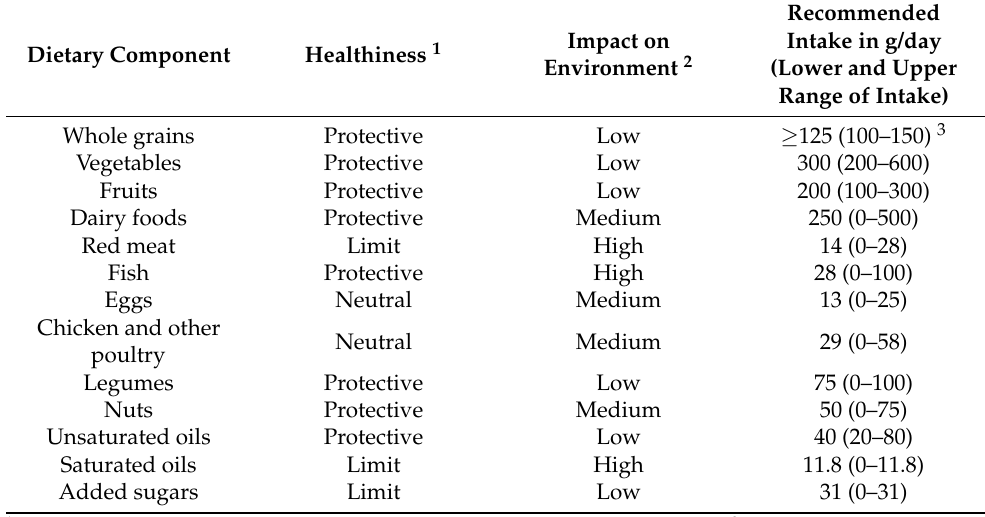
Table 1. The components included in the World Index for Sustainability and Health